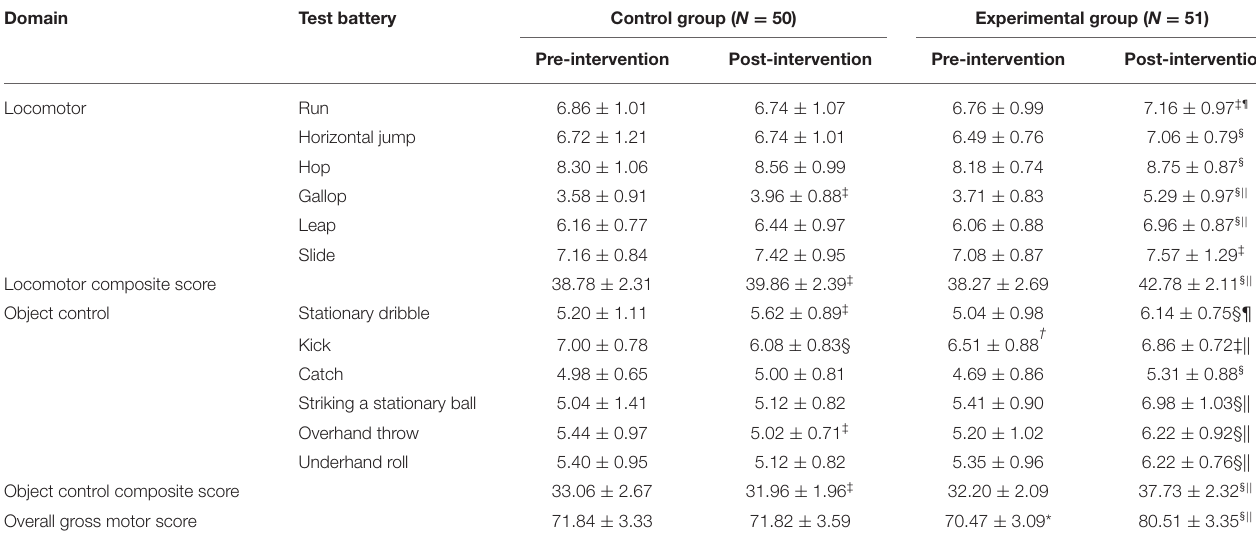
TABLE 4 | Results of gross motor.